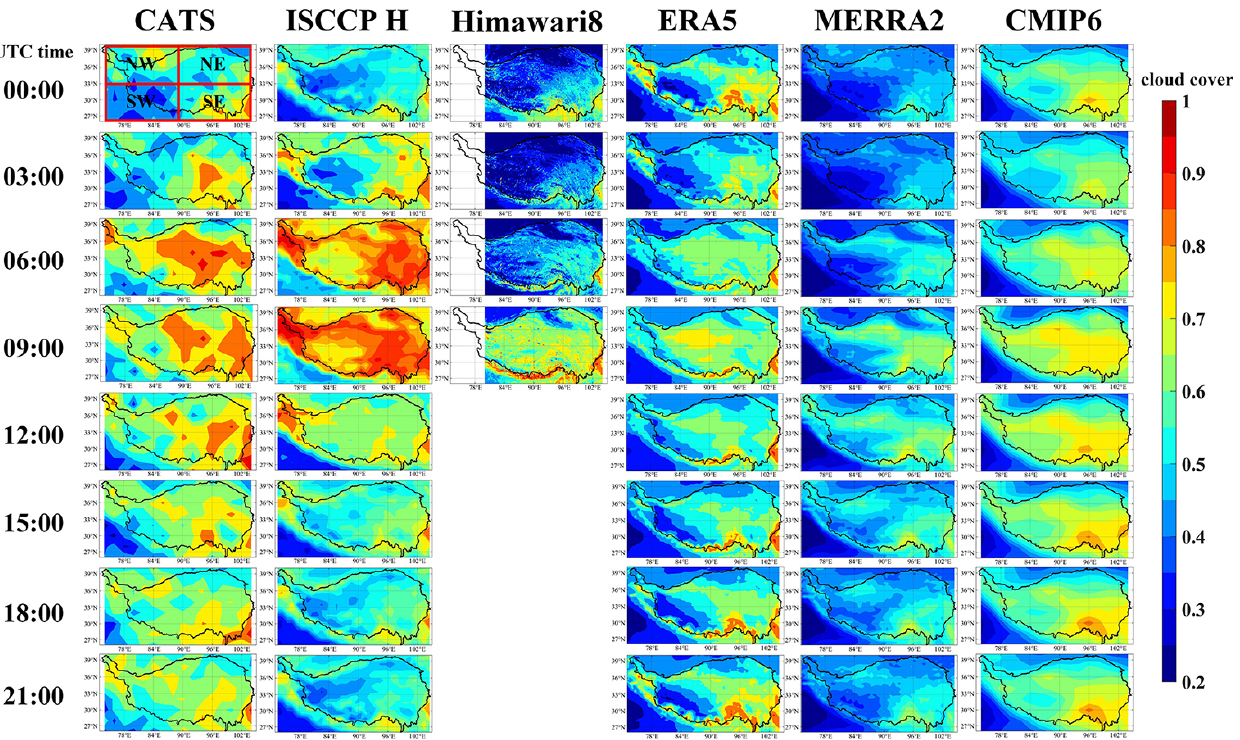
Figure 1. The spatial distribution of 3-hourly averaged total cloud cover over the TP based on CATS, ISCCP-H, Himawari-8, ERA5, MERRA-2, and CMIP6 multimodel mean. The different TP regions involved in this study are shown in the upper-left